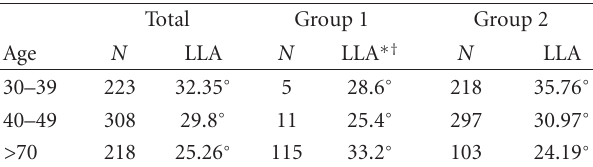
Table 1: Lumbar lordosis and age.